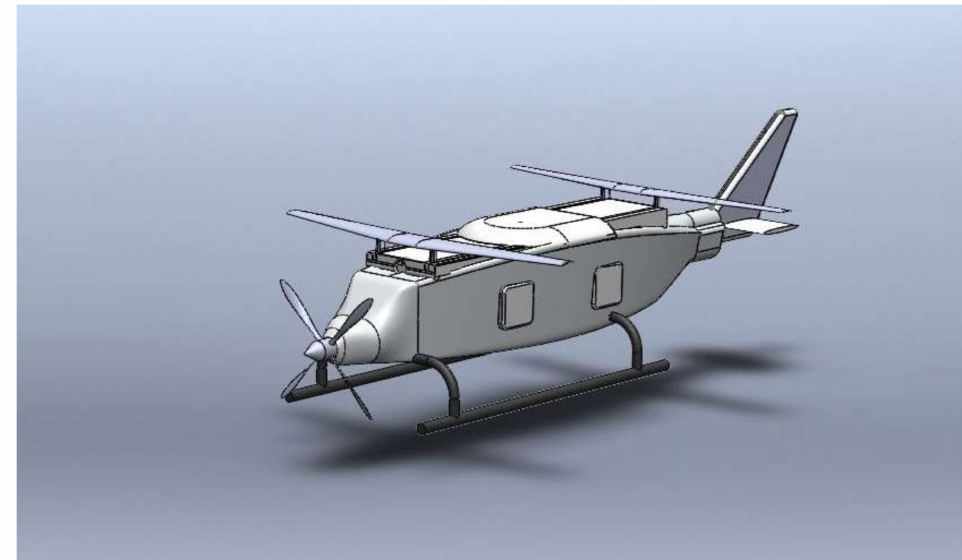
Figure 5. A snapshot of the animation of a SolidWorks conceptual design of an RA-driven VTOL